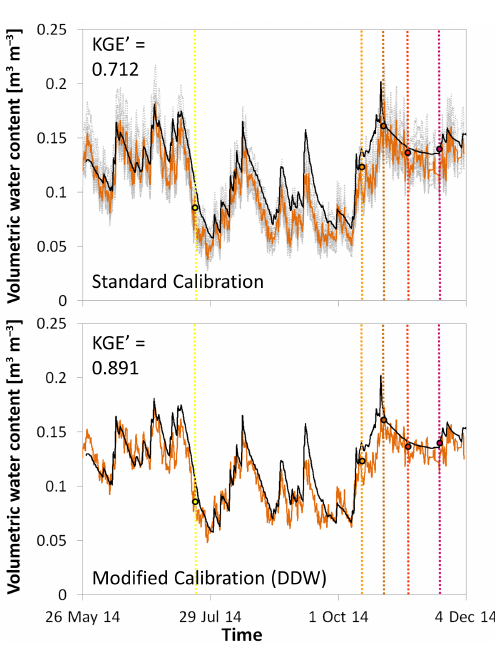
Figure 7. Average volumetric water content derived from TDT point measurements (black line) and CRS measurements (orange line) using different calibration functions. Upper panel: the orange line is an average of the volumetric water content derived from the 10 calibration campaigns of the CRS, using the standard N 0 - calibration function from Desilets et al. (2010) applying the DDW approach. Grey dotted lines are results for 10 individual calibra- tion campaigns (KGE (cid:48) values range from 0.579 to 0.834). Lower panel: the orange line is the volumetric water content derived from the calibration function with modified calibration parameters apply- ing the DDW weighting approach based on all 10 calibration dates. The colored vertical lines mark the days of the last five calibration campaigns.